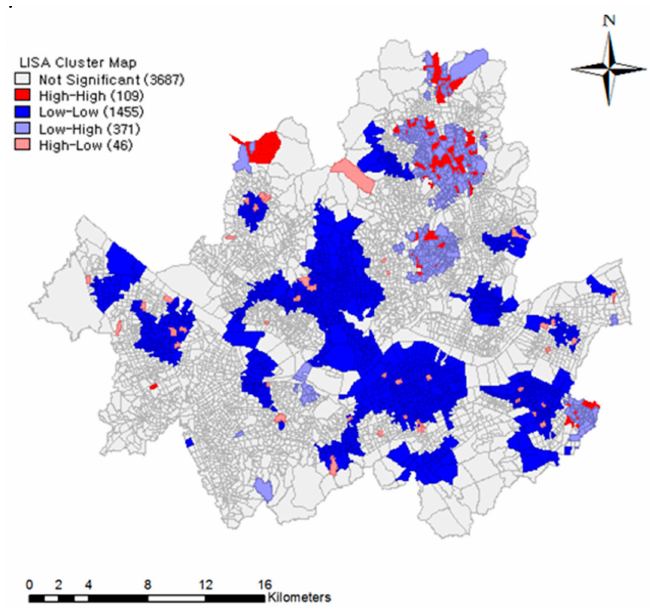
Figure 7. Local Moran’s I: Hot and cold spots of mini-solar